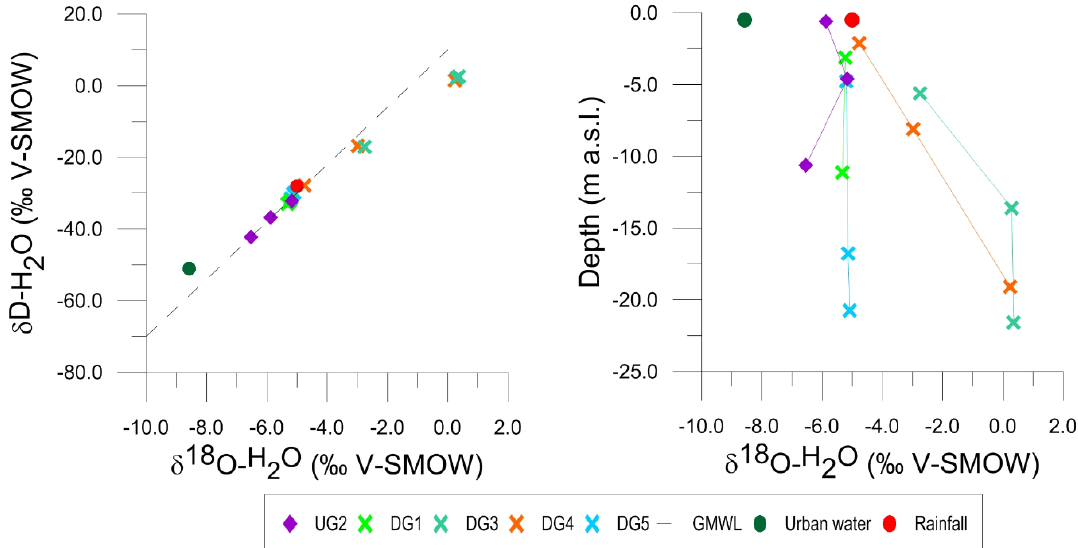
Figure 3. δ 18 O –δD ( left ) and δ 18 O-depth ( right ) plots in samples analysed from MLS, located upgradient (UG2) and downgradient (DG1, DG3, DG4, DG5), respectively, with respect to the hydraulic barrier (see Figure 1 for sampling site